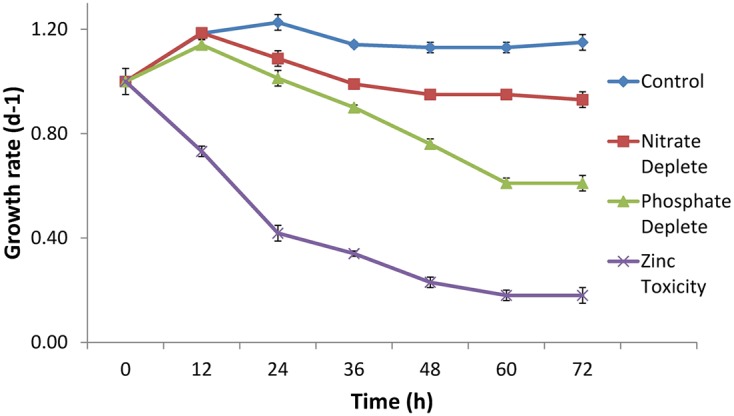
Growth rate of Synechococcus CB0101 during a 72 h period under different stress conditions: control medium, nitrogen limitation, phosphate limitation, and zinc toxicity (n = 3). See Chapter 3 for detailed explanation on Synechococcus CB0101 response to these conditions.